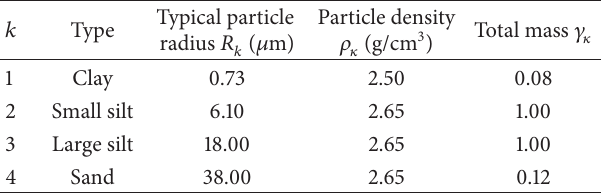
Figure 1: Area of simulation. Table 1: Feature of typical dust